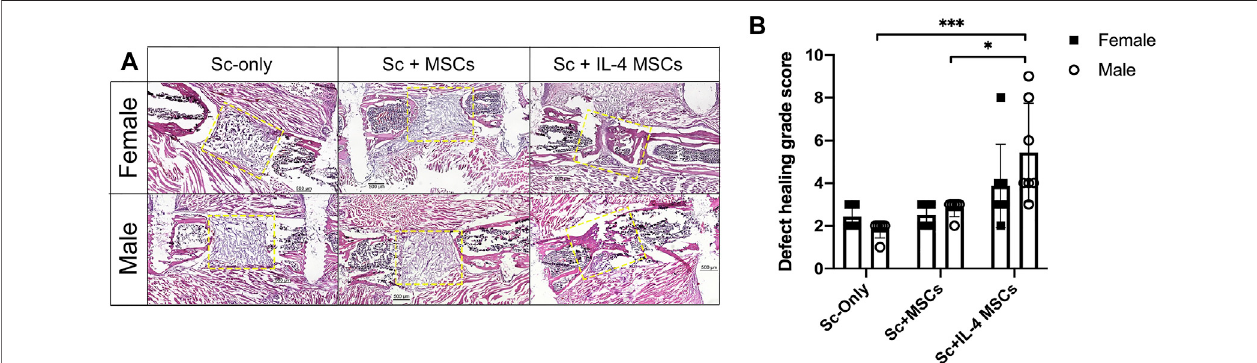
FIGURE 3 | Histology analysis ofcritical size bone defect healingafter 6 weeks in female and male mice. (A) H&E stained representative images of the bone defect images (scaffolds ± cells) at 200x magni fi cation. The yellow dotted frames show the original bone defect area. (B) Defect healing grade score based on the histological